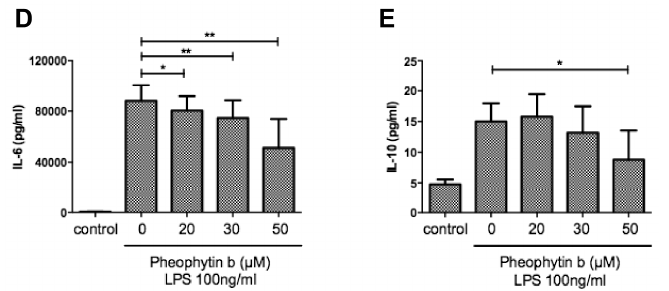
Figure 6. Effects of pheophytin-b on LPS-induced PGE2 and cytokine expression profiles by human CD14 + monocyte-derived macrophages. Human CD14 + monocyte-derived macrophages were pre-treated with the indicated concentrations of pheophytin-b for 30 min followed by LPS (100 ng/mL) for 24 h. The secretions of PGE2 ( A ), TNF- α ( B ), IL-1 β ( C ), IL-6 ( D ), and IL-10 ( E ) from LPS-induced cells pre-treated with/without pheophytin-b were measured. Results show the means ± standard deviation of three experiments. * p < 0.05, ** p < 0.01, *** p < 0.001 vs. cells treated with LPS alone (Student’s t -test, n = 3).